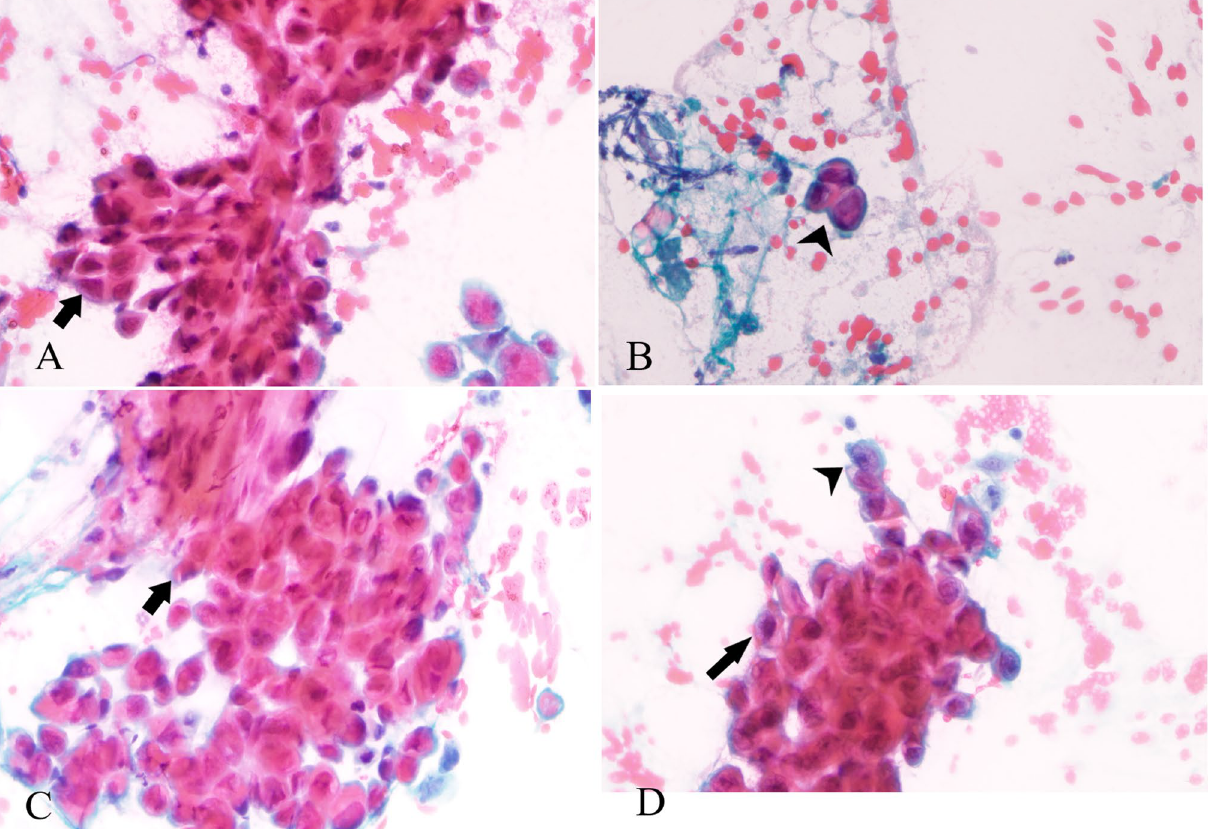
Fig. 2 Microphotograph of fine needle aspiration cytology pathological findings that support the diagnosis of high grade MEC from the parotid gland origin (X40 H&E). A , C Smears groups of atypical epithelial cells (black arrow) with eosinophilic cytoplasm with enlarged and irregular nuclei, prominent nucleoli. B Smear showing some mucin-secreting vacuolated cells (black arrowhead). D Some mucin-secreting (black arrowhead) intermixed with atypical epithelial cells (black